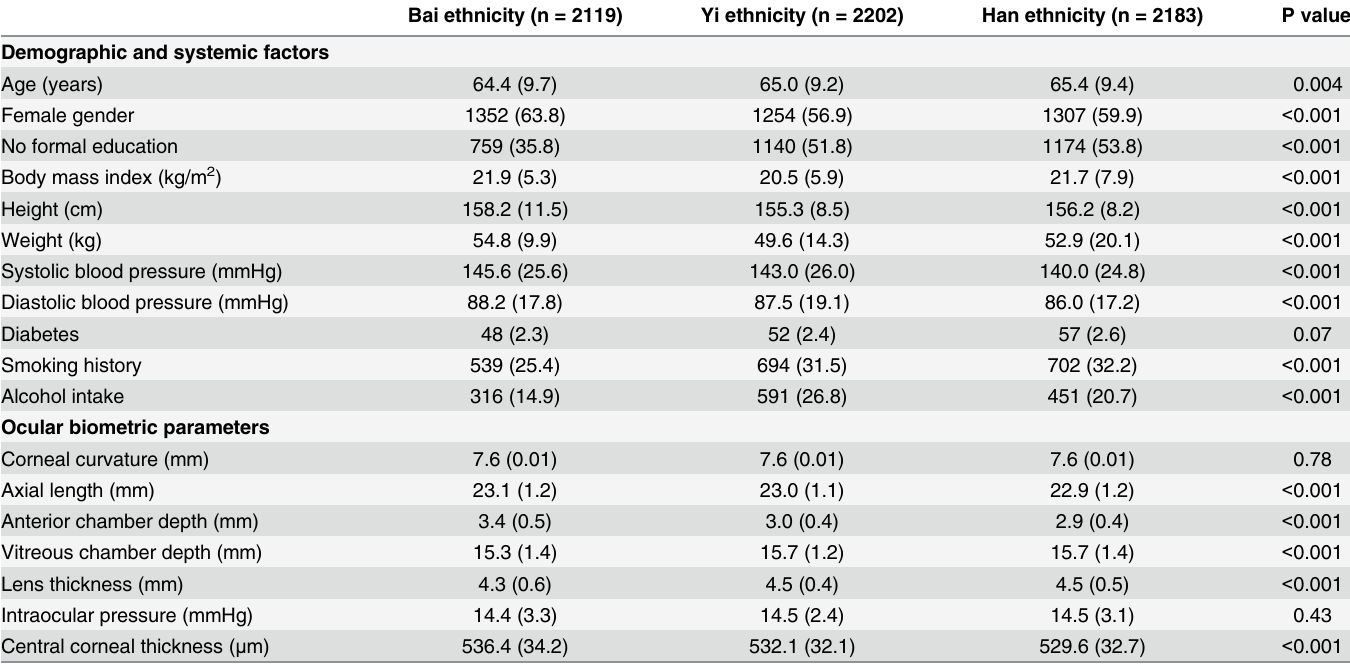
Table 1. Demographic, systemic and ocular parameters among the three ethnic groups. Bai ethnicity (n = 2119) Yi ethnicity (n =